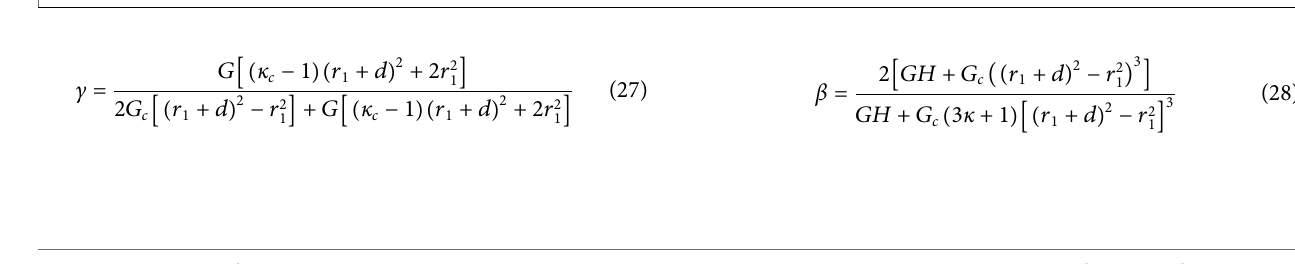
Frontiers in Earth Science |